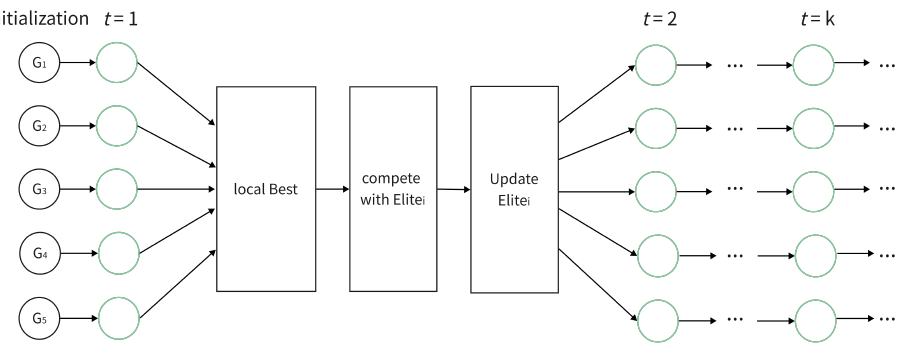
Figure 1. The communication strategy with random replacement.